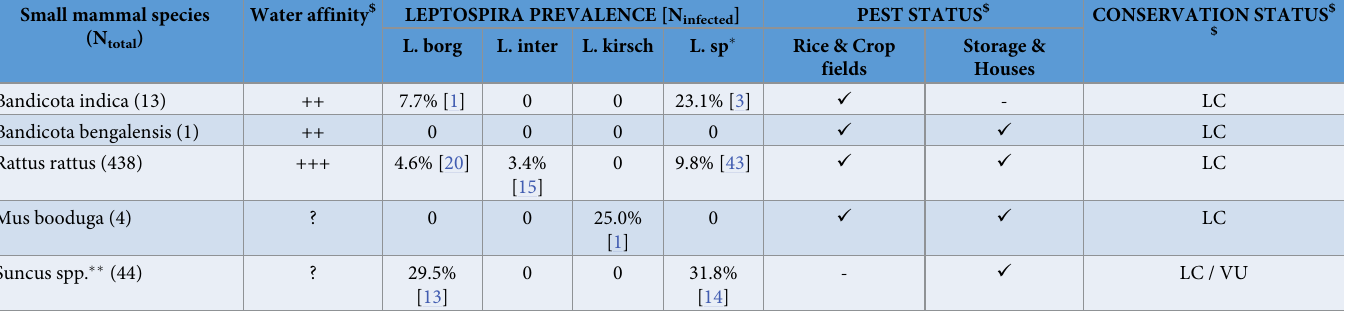
Table 3. Leptospira prevalence in rodent species and shrews present in smallholder food storage facilities in Sri Lanka including pest and conservation status. L. borg is L . borgpetersenii , L. inter is L . Interrogans , L. kirsch is L . kirschneri and L. sp is total Leptospira spp. N is sample size, LC—least concern, VU—vulnerable.